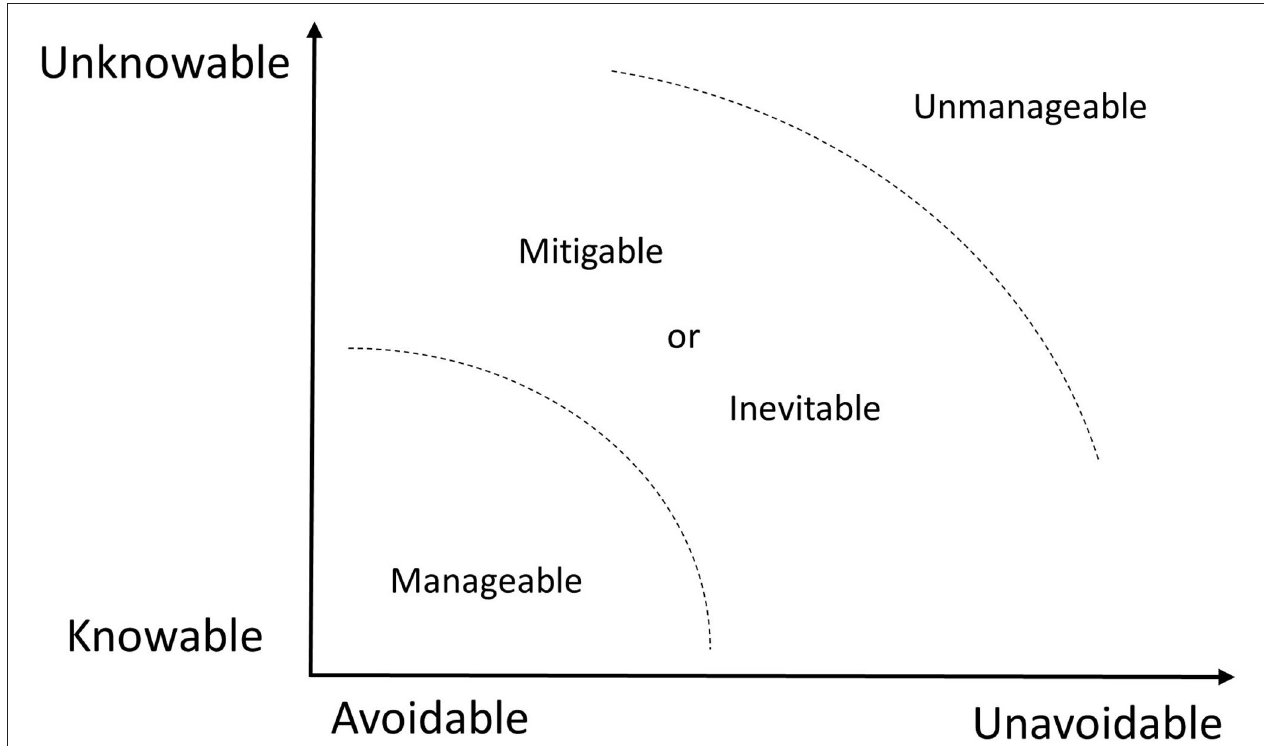
FIGURE 1 | Framework of unintended